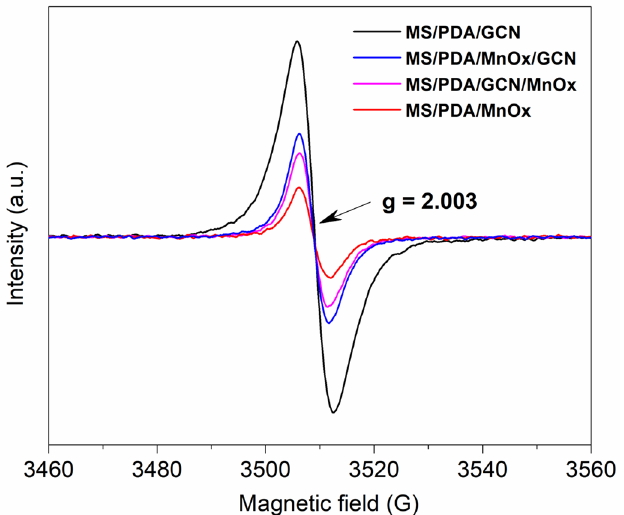
Figure 7. ESR test for the catalysts MS/PDA/GCN, MS/PDA/MnOx/GCN, MS/PDA/GCN/MnOx and MS/PDA/MnOx.